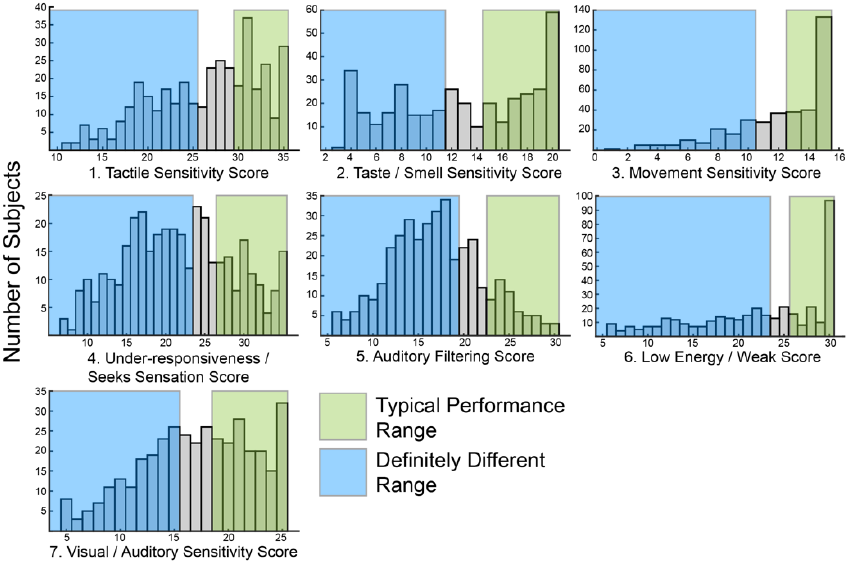
Figure 1. Histograms showing the distribution of raw scores for each of the seven sensory areas defined by the Short Sensory Profile (SSP).